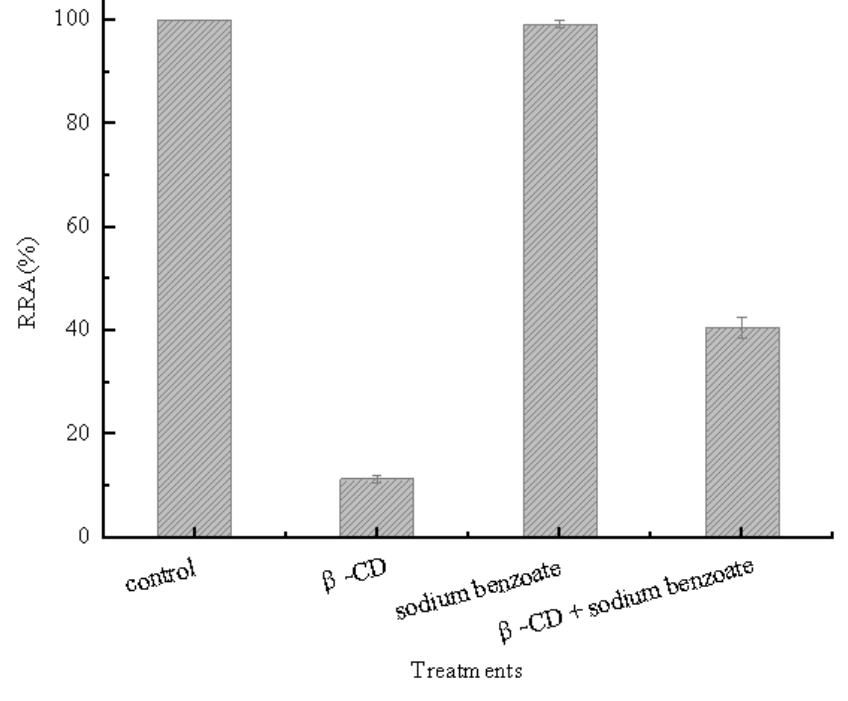
Figure 1. Effects of hydrophobic cavities on pullulanase activity.